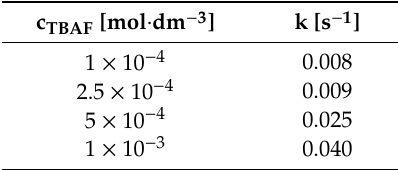
Table 2. Change of the isomerization rate constant k [s − 1 ] Z anion = E anion of compound 1 (1 × 10 − 5 mol·dm − 3 ) depending on the concentration of TBAF in DMF (25 °C).